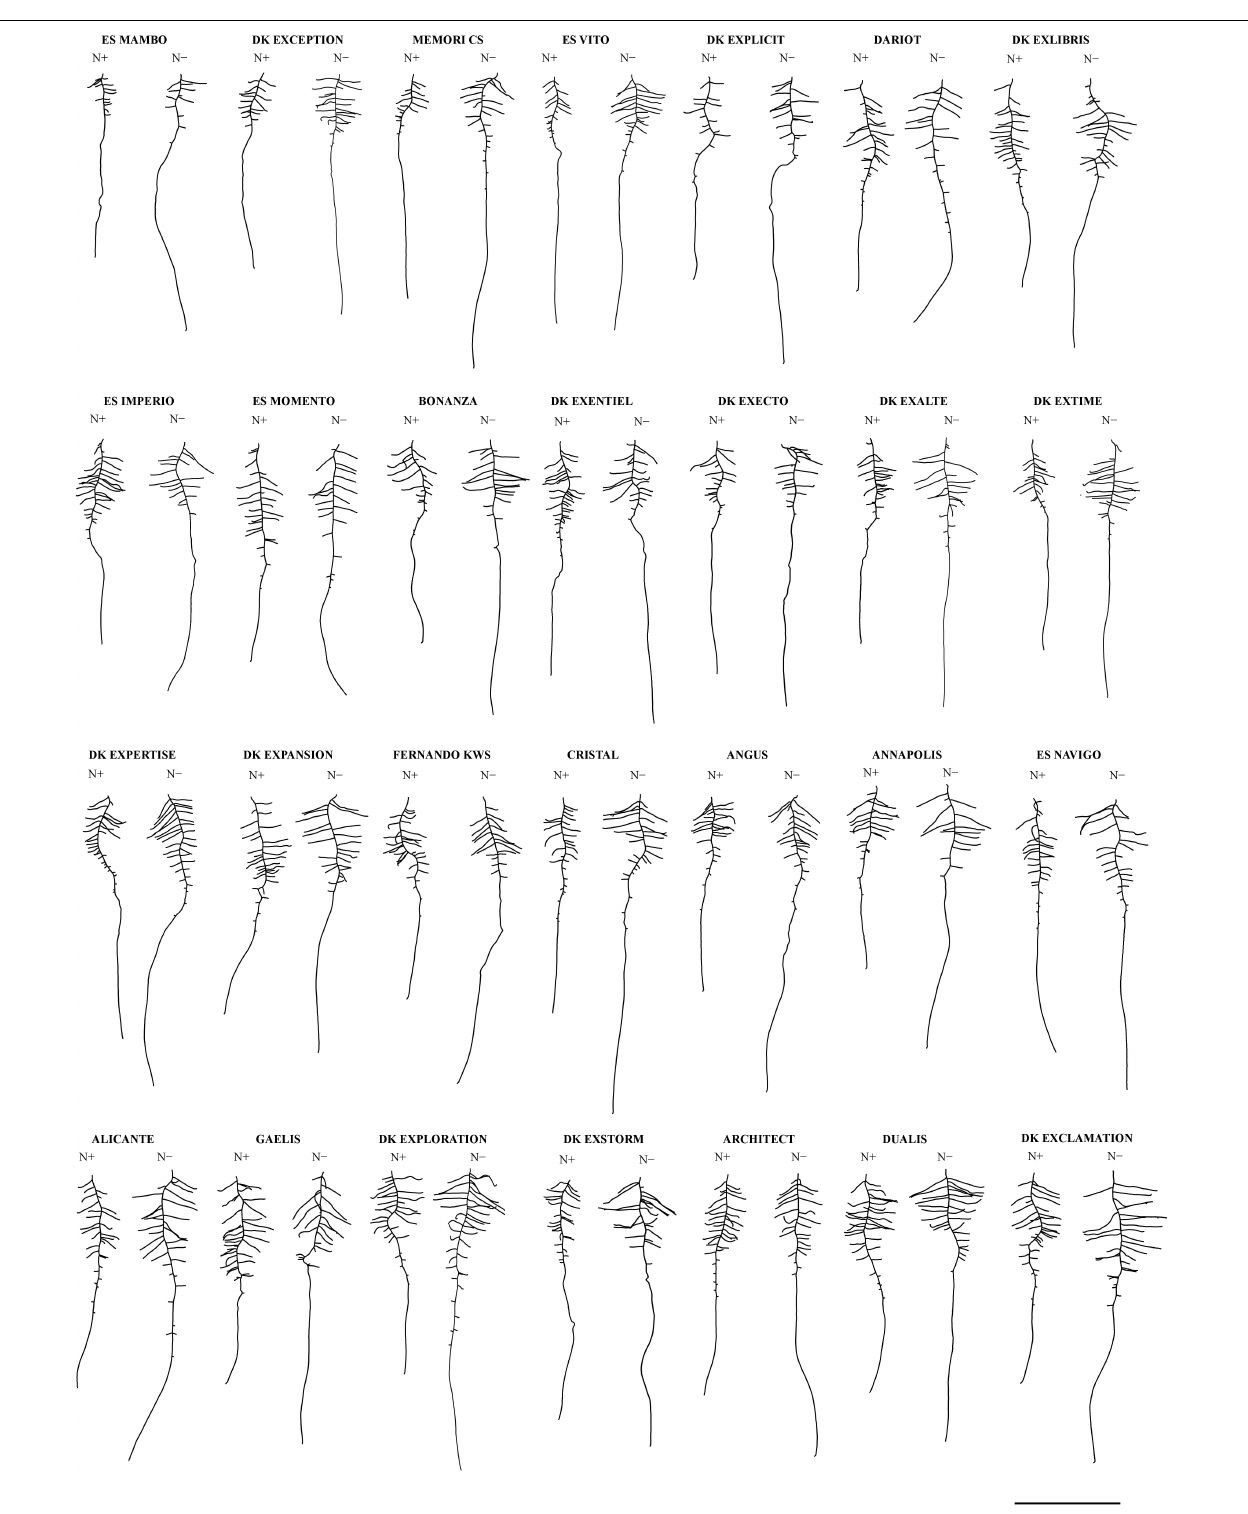
Frontiers in Plant Science |